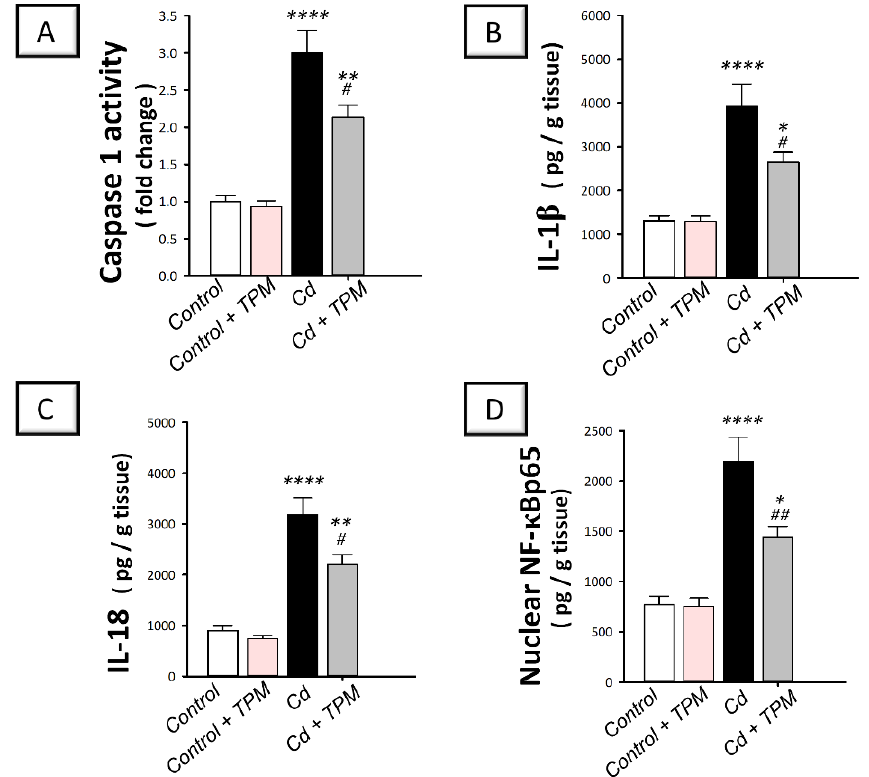
Figure 4. Effect of cadmium and/or topiramate on caspase-1/IL-1 β /NF- κ B pathway in testes of rats. The co-treatment with topiramate suppressed testicular caspase-1/IL-1 β pathway that was activated by cadmium administration. This was revealed by lowered activity of caspase 1 [H (3, 20) = 29.61, p < 0.0001] ( A ) and decreased levels of the pro-inflammatory IL-1 β [H (3, 20) = 18.93, p < 0.0001] ( B ), and IL-18 [H (3, 20) = 31.92, p < 0.0001] ( C ). Meanwhile, the co-treatment with topiramate inhibited NF- κ B activation and lowered the nuclear levels of pro-inflammatory signal NF- κ B p65 [H (3, 20) = 22.35, p < 0.0001] ( D ). Results are demonstrated as the mean ± standard error of the mean (SEM) for six rats in each experimental group. * p < 0.05, ** p < 0.01, **** p < 0.0001 signifies statistical significance versus the control group; # p < 0.05, ## p < 0.01 signifies statistical significance versus cadmium chloride-treated group. IL-1 β , interleukin-1 beta; IL-18, interleukin 18; NF- κ B, nuclear factor kappa B. TPM, topiramate; Cd, cadmium chloride.